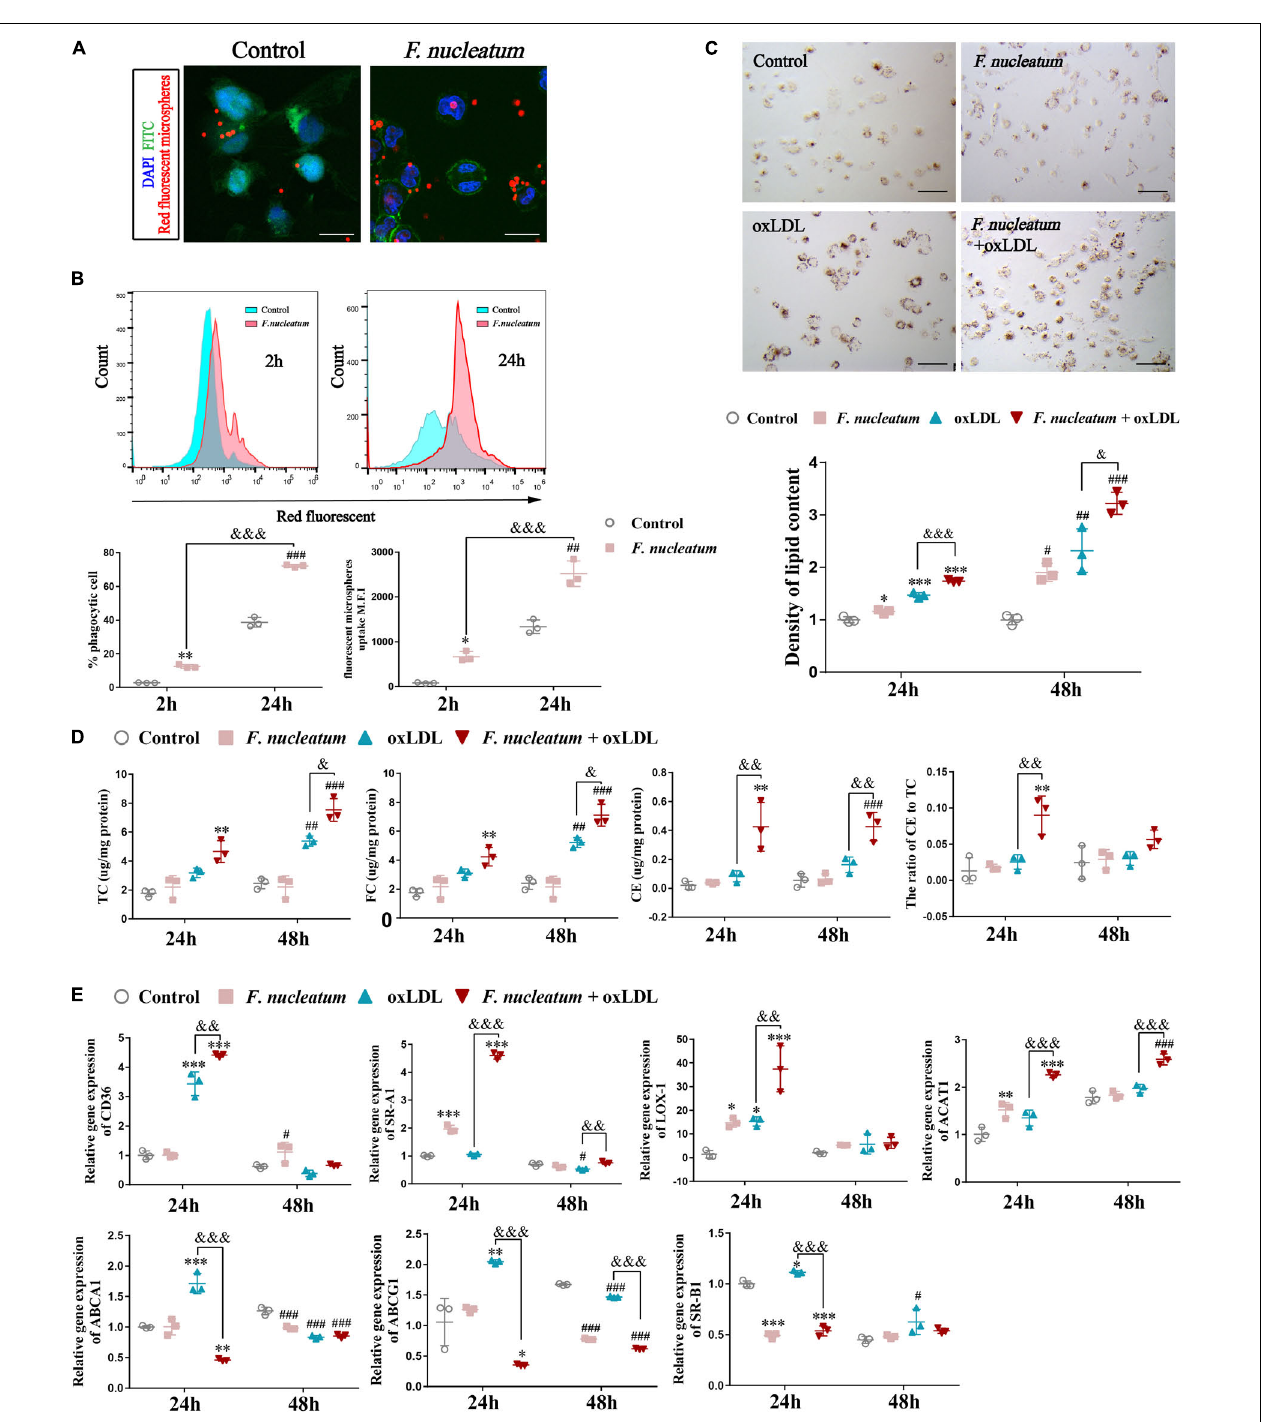
FIGURE 6 | F. nucleatum promotes macrophage phagocytosis and foam cell formation. (A) Representative confocal microscopy image exhibited the engulfment of fluorescent microspheres by macrophages for 2 h. F. nucleatum group, after 24 h infection. control group, uninfected. Scale bars, 25 µ m. (B) Flow cytometry analysis of 2 h fluorescent microspheres (50:1) uptake in macrophages after infection with F. nucleatum for 2 and 24 h at 37 ◦ C. The results were expressed as a percentage of positive phagocytosis and geometric mean fluorescence intensity (M.F.I.) after subtracting the autofluorescence of cells incubated in the absence of fluorescent microspheres. (C) Representative images of macrophages incubated with or without ox–LDL (50 µ g/ml) for 24 h, then stained with ORO. Scale bars, 75 µ m. The panel below shows the quantification of lipid droplets accumulated in the cytoplasm at 24 and 48 h, which were released using isopropyl alcohol and measured at 510 nm. Data were expressed as relative density to the control group. (D) Quantification of total cholesterol (TC), free cholesterol (FC), cholesterol esters (CE), and